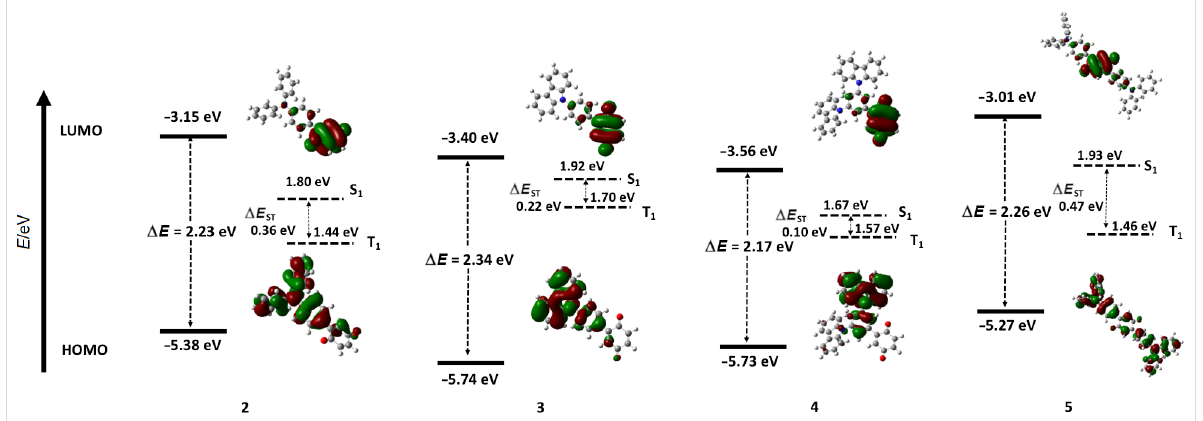
Figure 3: HOMO/LUMO and S 1 /T 1 energies as well as HOMO/LUMO electron density distribution profiles of 2 – 5 .